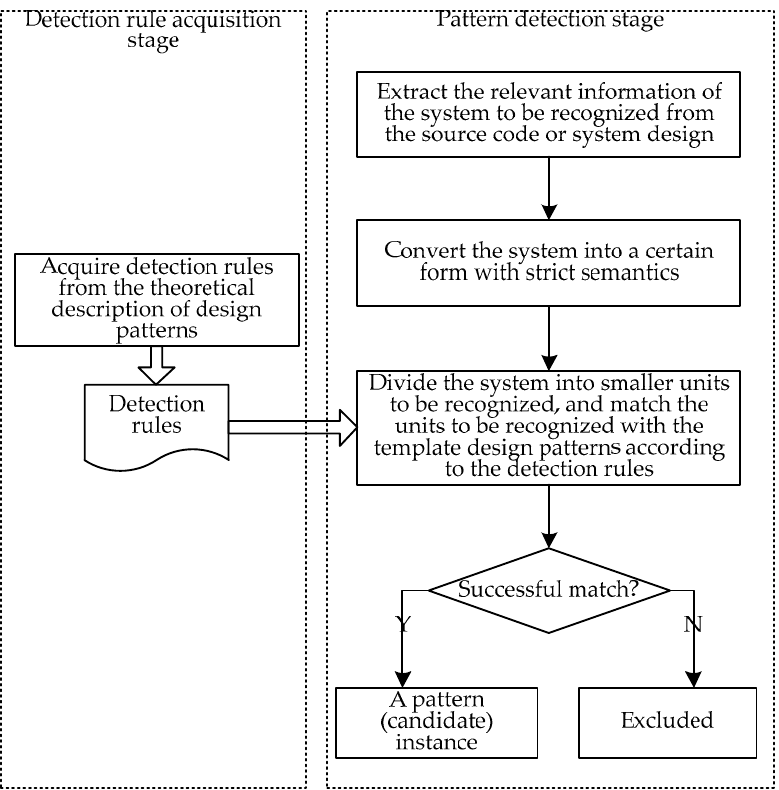
Figure 1. The basic flow of non-machine learning design pattern detection methods.